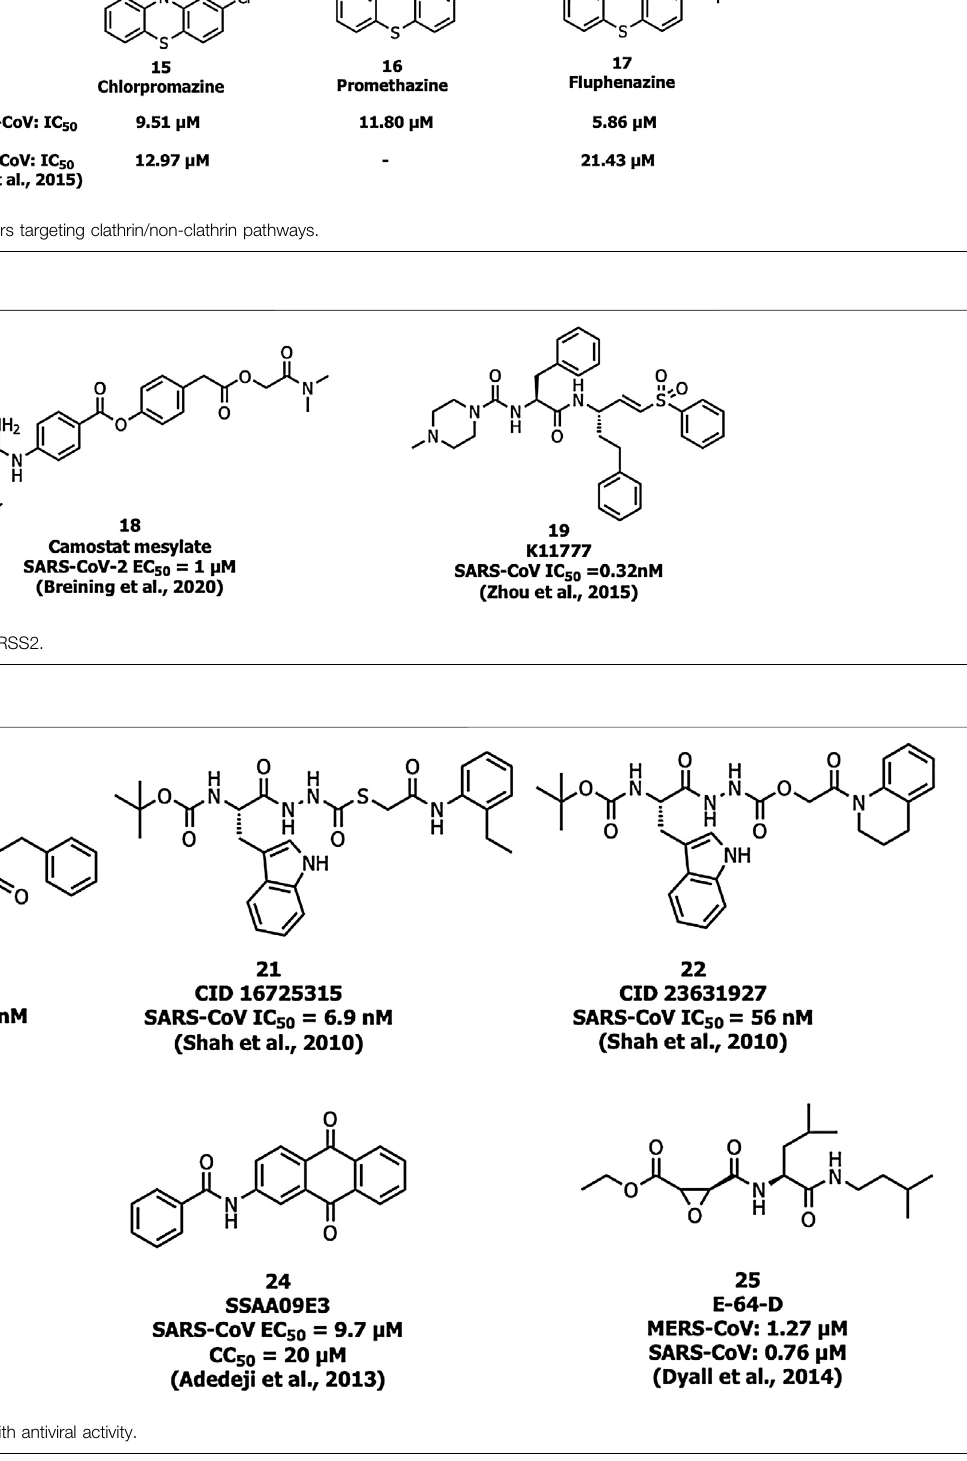
Frontiers in Molecular Biosciences |